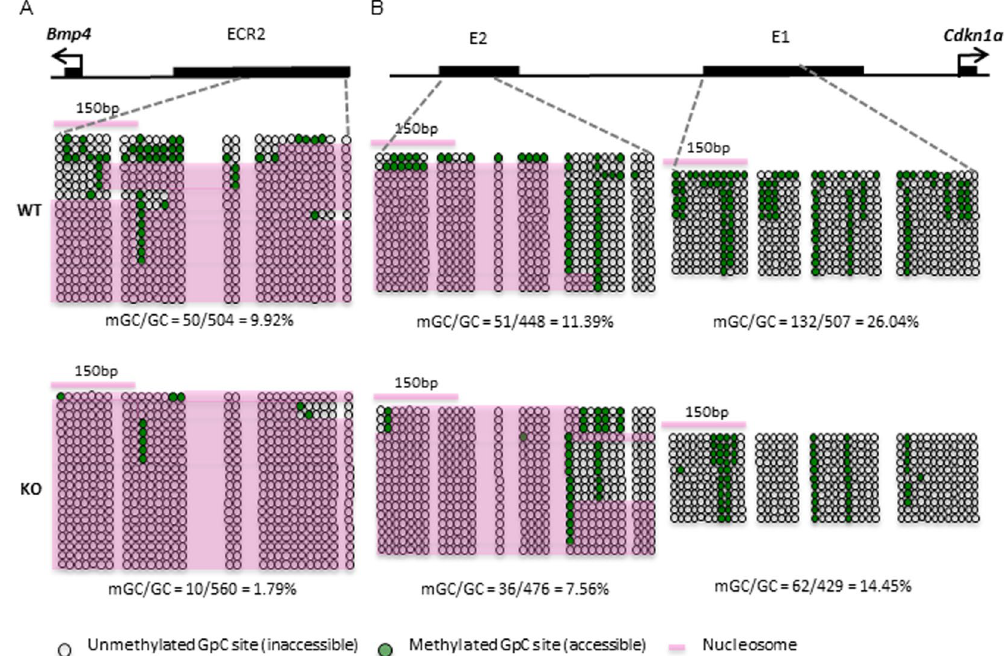
Figure 5. Altered nucleosome occupancy at the regulatory regions of Bmp4 and Cdkn1a . GpC methylation and nucleosome position assay by NOME-seq at Bmp4 enhancer region ( A ) and Cdkn1a enhancer regions ( B ). WT and KO samples for NOMe-seq assay n = 2. A similar change in nucleosome occupancy was observed in a biologic repeat (Supplement Fig.